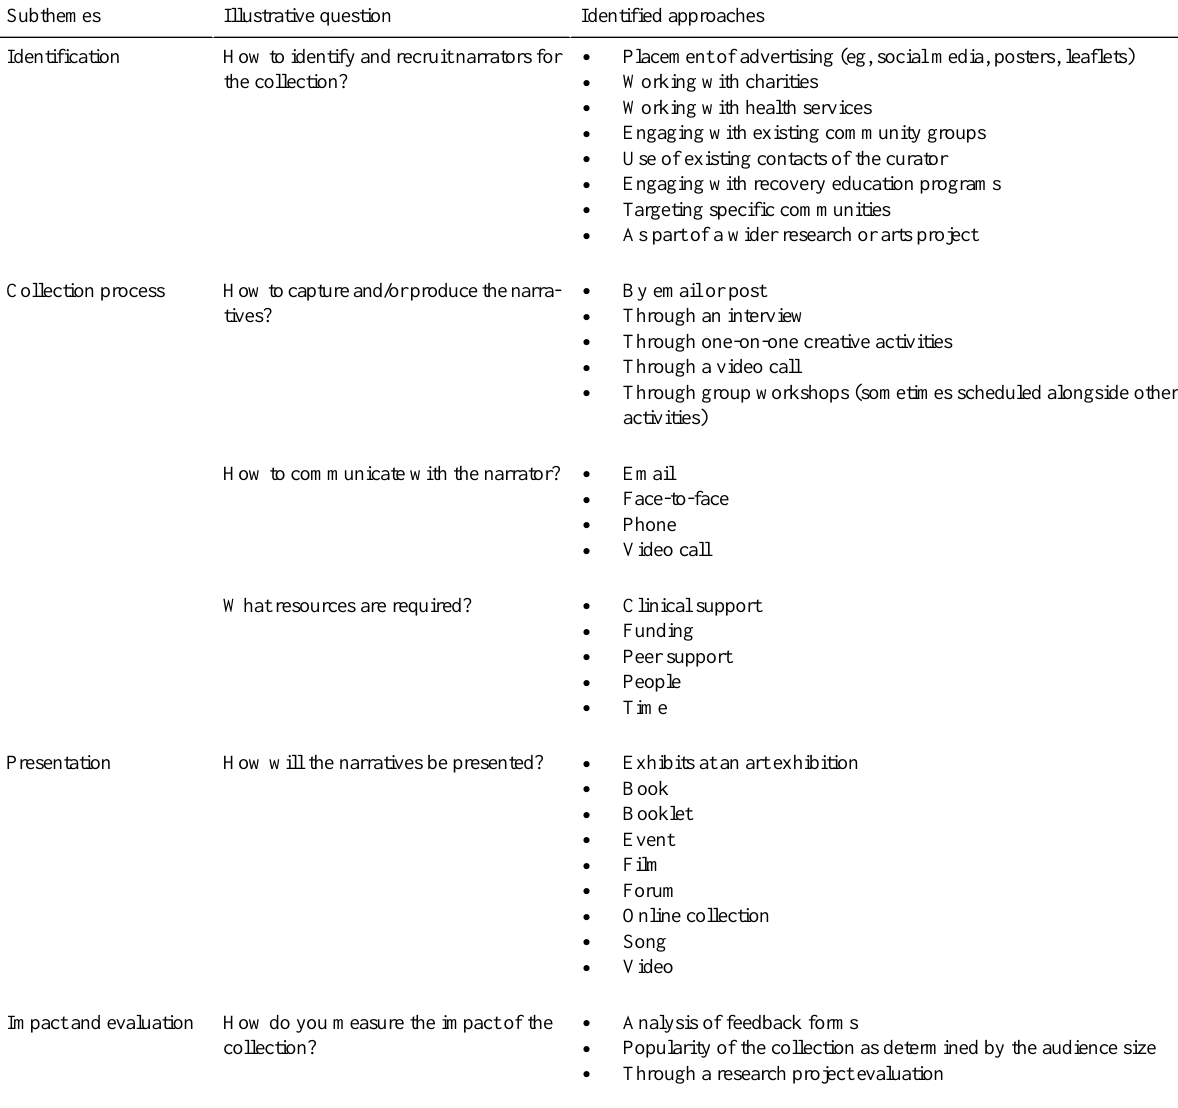
Table 3. Organizing and presenting